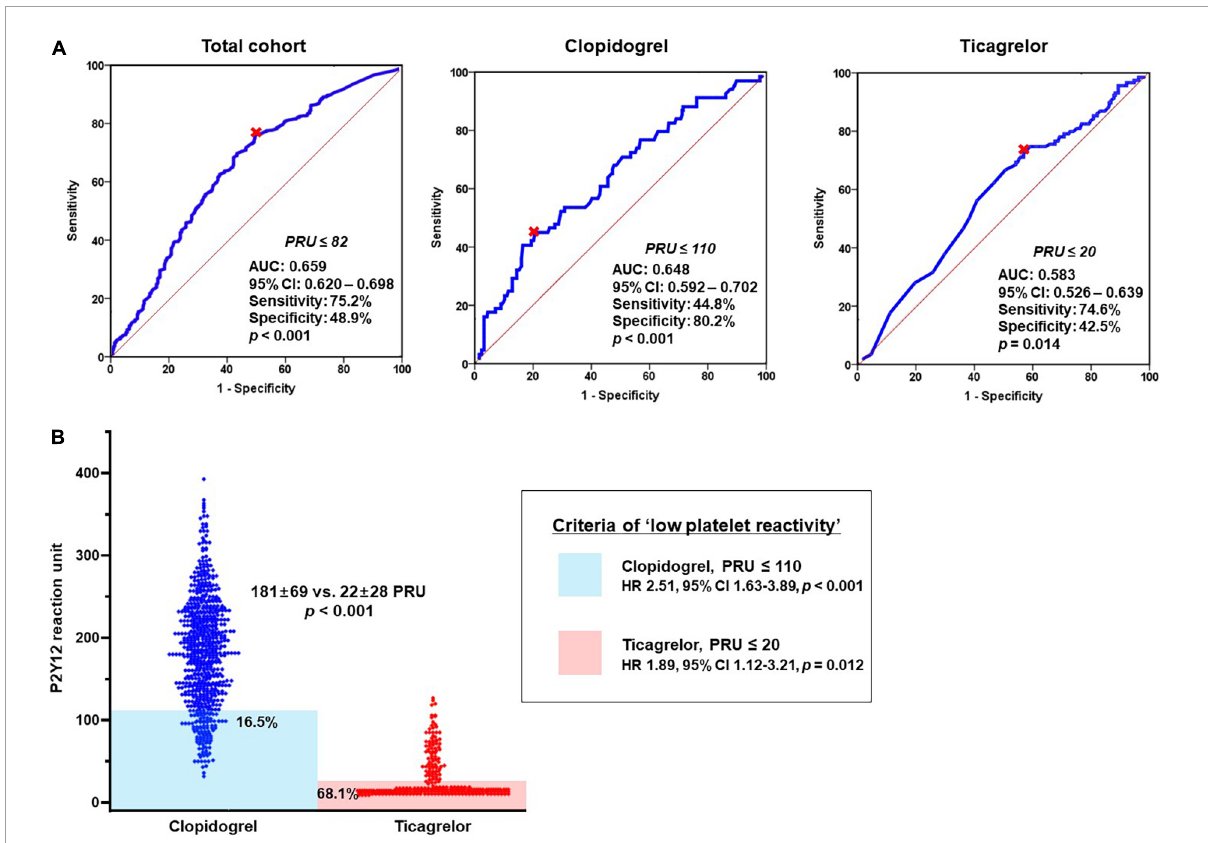
FIGURE3 Association between bleeding episode and platelet reactivity according to DAPT regimen. (A) ROC curve analysis: the cutoffs of ‘low platelet reactivity’ and (B) Prevalence of ‘low platelet reactivity’ according to type of P2Y 12 inhibitor. AUC, area under curve; CI, confidence interval; DAPT, dual antiplatelet therapy; OR, odds ratio; PRU, P2Y12 reaction unit; ROC, receiver-operating characteristics.